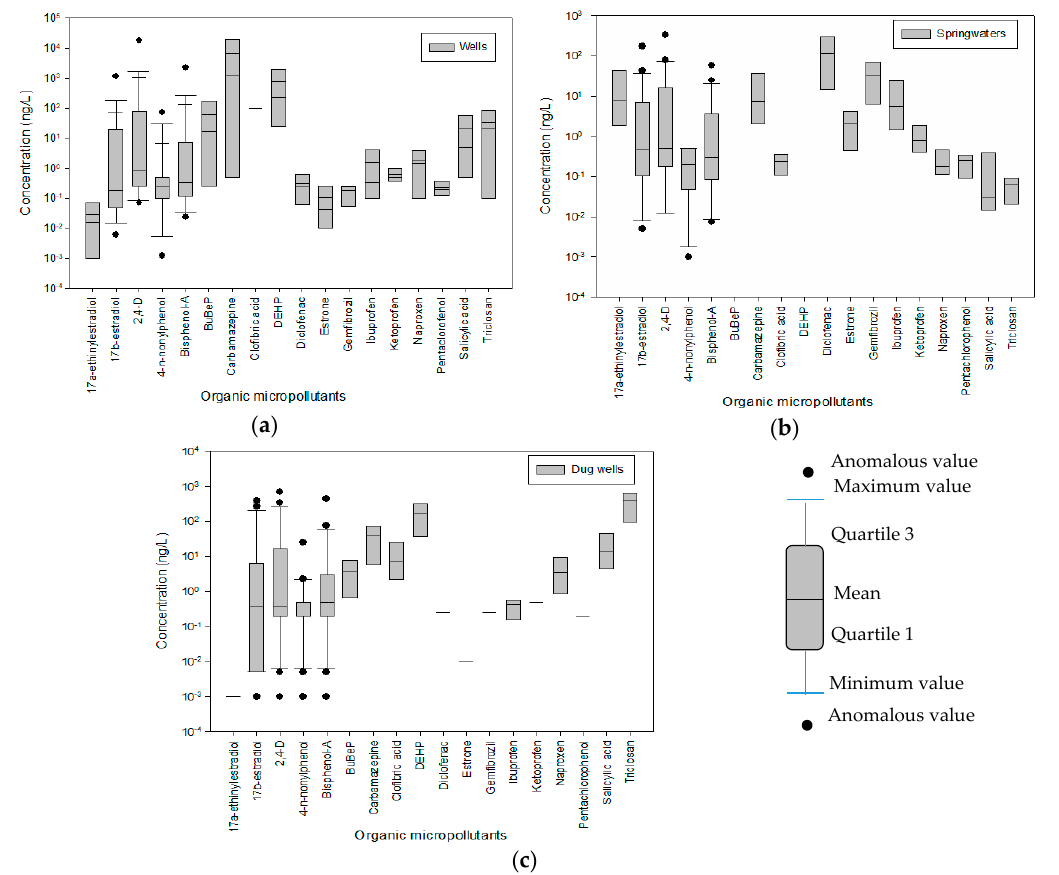
Figure 4. Presence of OMPs in Tula Valley in: ( a ) wells, ( b ) spring water, and ( c ) dug wells.